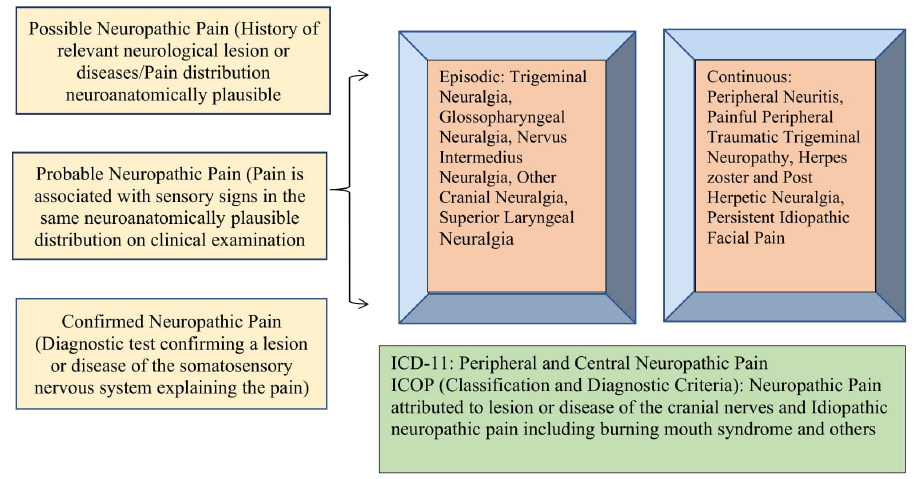
Figure 1. Types of orofacial neuropathic